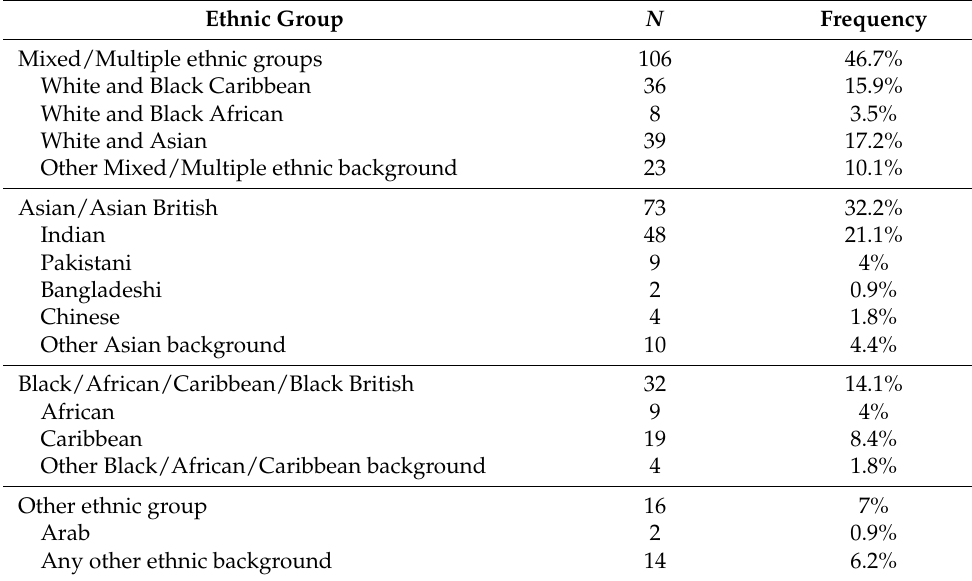
Table 2. Ethnic background of